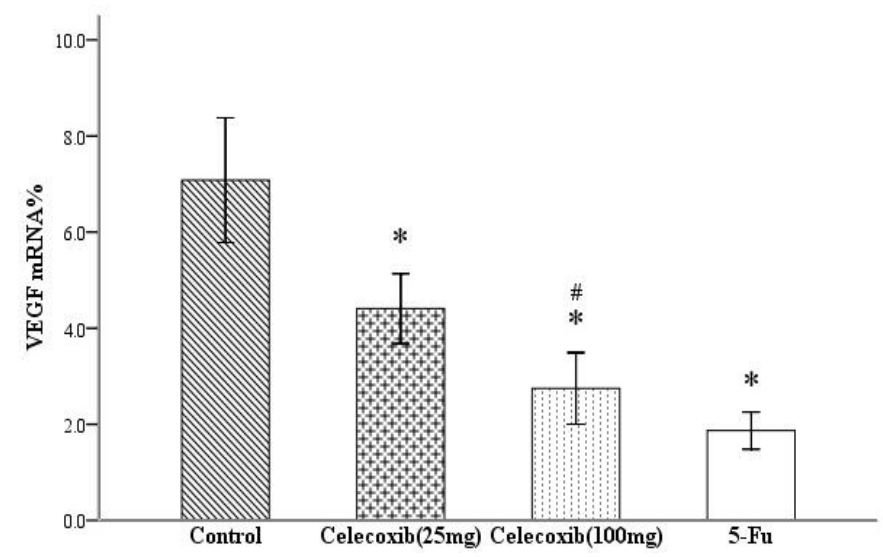
Figure 2. Effects of the drugs on the expression of VEGF. mRNA levels of VEGF were decreased in treatment groups. * P < 0.05 compared with control, # P < 0.05 compared with Celecoxib-25 mg group, error bars indicate